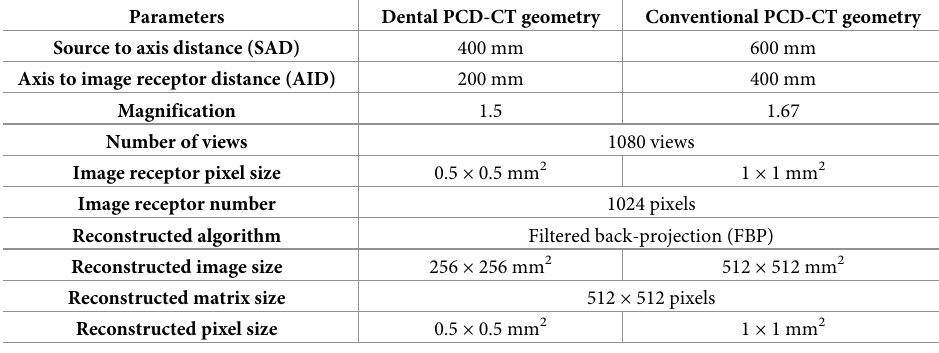
Table 1. The parameters for data acquisition and image reconstruction for the PCD-CT imaging simulations.